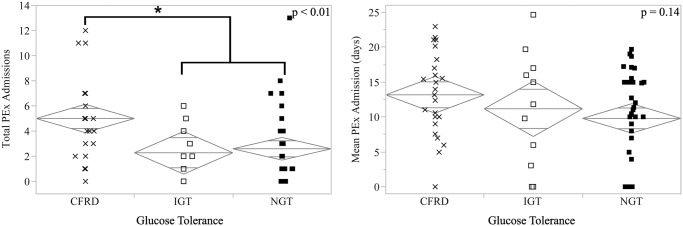
Glucose tolerance and two-year pulmonary exacerbation history.CFRD subjects had approximately twice as many pulmonary exacerbations as subjects with impaired (IGT) or normal glucose tolerance (NGT, left panel). The average length of admission was not significantly different between these groups (right panel). Diamonds are centered on each category’s mean and the vertical distance represents the 95% confidence interval.